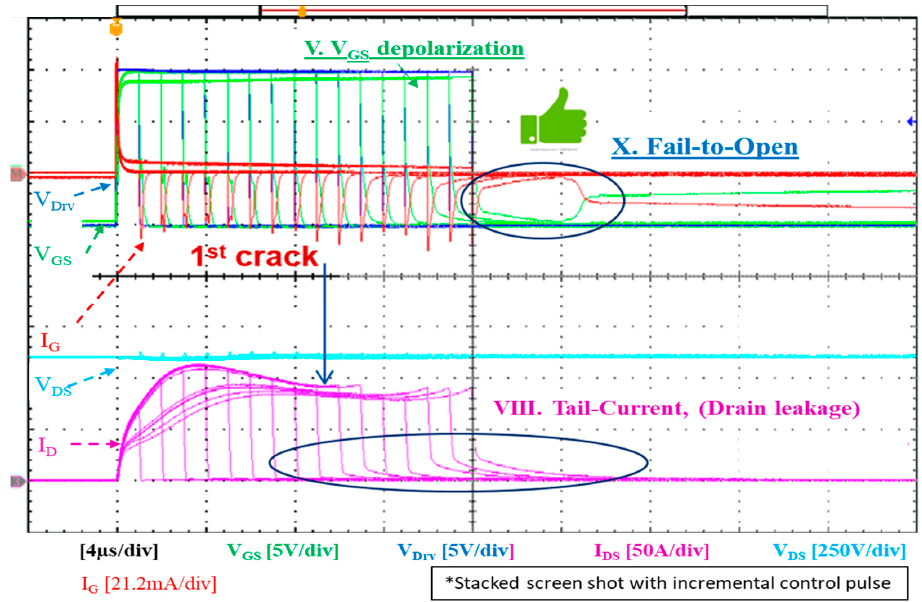
Figure 8. Stacked incremental pulse duration oscilloscope waveforms from 1 µs to 16 µs with a step of 1 µs. @V DS = 600 V, R G = 47 Ω , V Drv = − 5 V/10 V, DUT